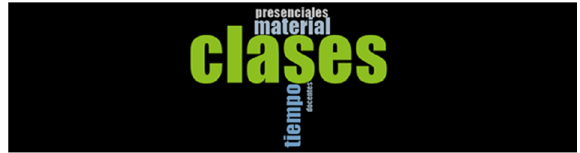
Fig. 4 Suggested improvements in materials and resources. From: Data obtained from question no. 11 of the survey (open type). Tag cloud. Compiled by the authors based on the information provided by the software Nvivo. The translation of the words from Spanish to English in descending order from highest to lowest